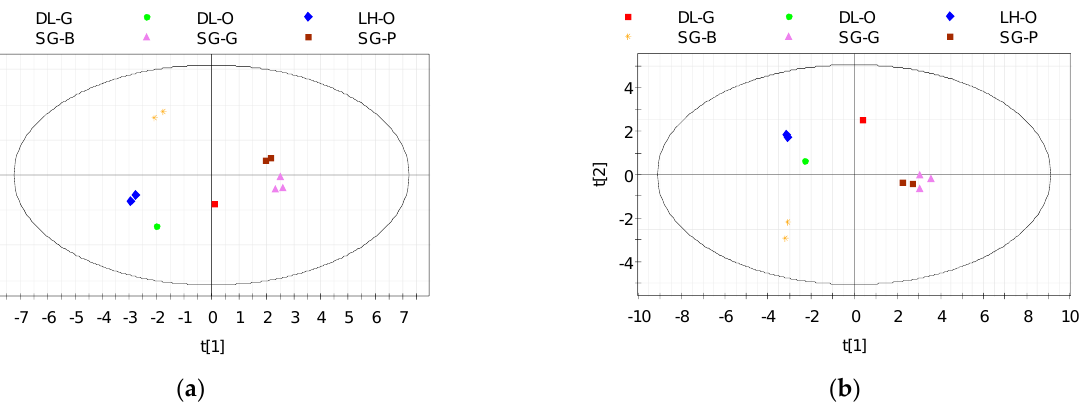
Figure 2. The PCA scores of the first two principal components for 11 tea samples in Vietnam based on ( a ) 6 variables: TPCs, TFCs, DPPH, ABTS, FRAP, and CUPRAC with 96.5% of the cumulative variance of the two first components; and ( b ) 14 variables: TPCs, TFCs, DPPH, ABTS, FRAP, CUPRAC, caffeine, gallic acid, 5 major catechins, and total catechins with 82.3% of the cumulative variance of the two first components.